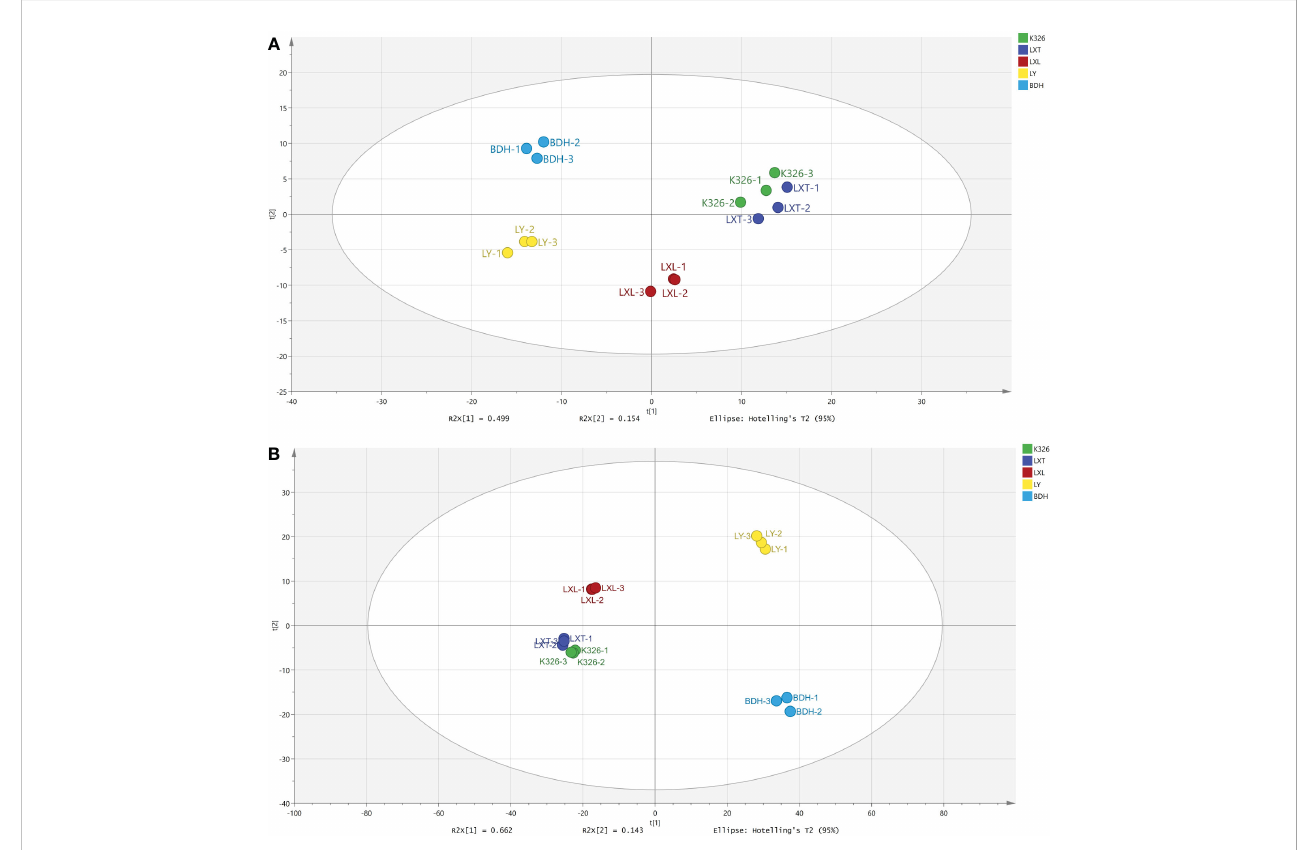
FIGURE 1 Metabolite variation among fi ve tobacco varieties. (A) PCA score plot for the 309 annotated volatile metabolites (R 2 X = 0.923, Q 2 = 0.783). (B) PCA score plot for the 1168 annotated non-volatile metabolites (R 2 X = 0.932, Q 2 =